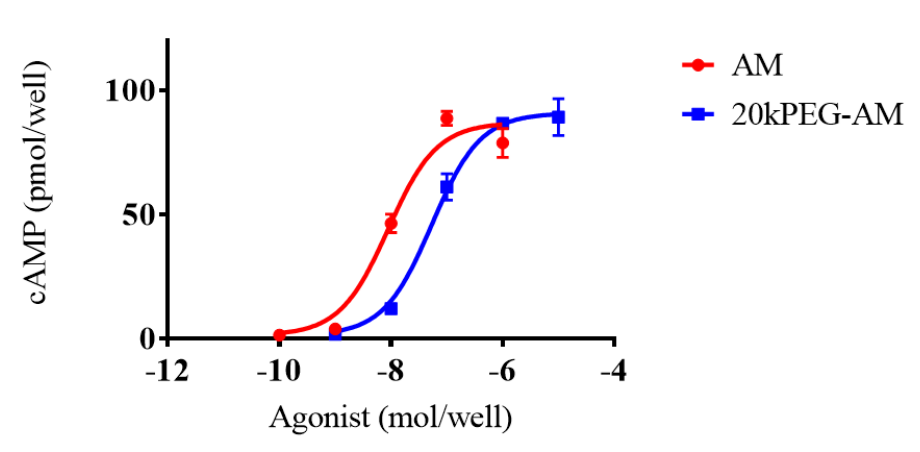
Figure 2. Intracellular cAMP accumulation following treatment of cultured HEK-293 cells with 20kPEG-AM or native AM. HEK-293 cells stably expressing the type 1 AM receptor were treated with the indicated concentrations of 20kPEG-AM or native AM for 15 min. Intracellular cAMP levels were measured using an enzyme immunoassay. Data are presented as the means ± S.E.M. of five replicates for each concentration.